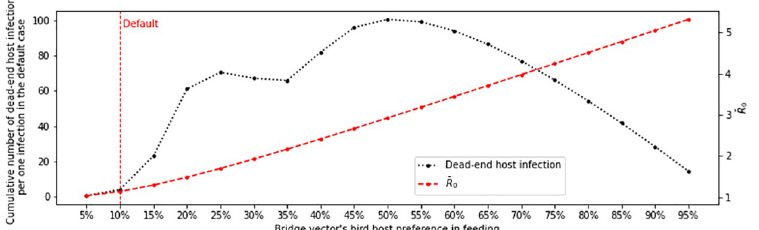
Fig 8. Cumulative dead-end host infections and � R for different bridge vector host preference ratios. The current 0 host preference is 10%. As feeding preference shifts from 90% dead-end host and 10% avian there is an increase in total . Disease burden is maximized at 50% dead-end host and 50% avian, while � R dead-end host cases and � R 0 at 0% dead-end host and 100% avian.